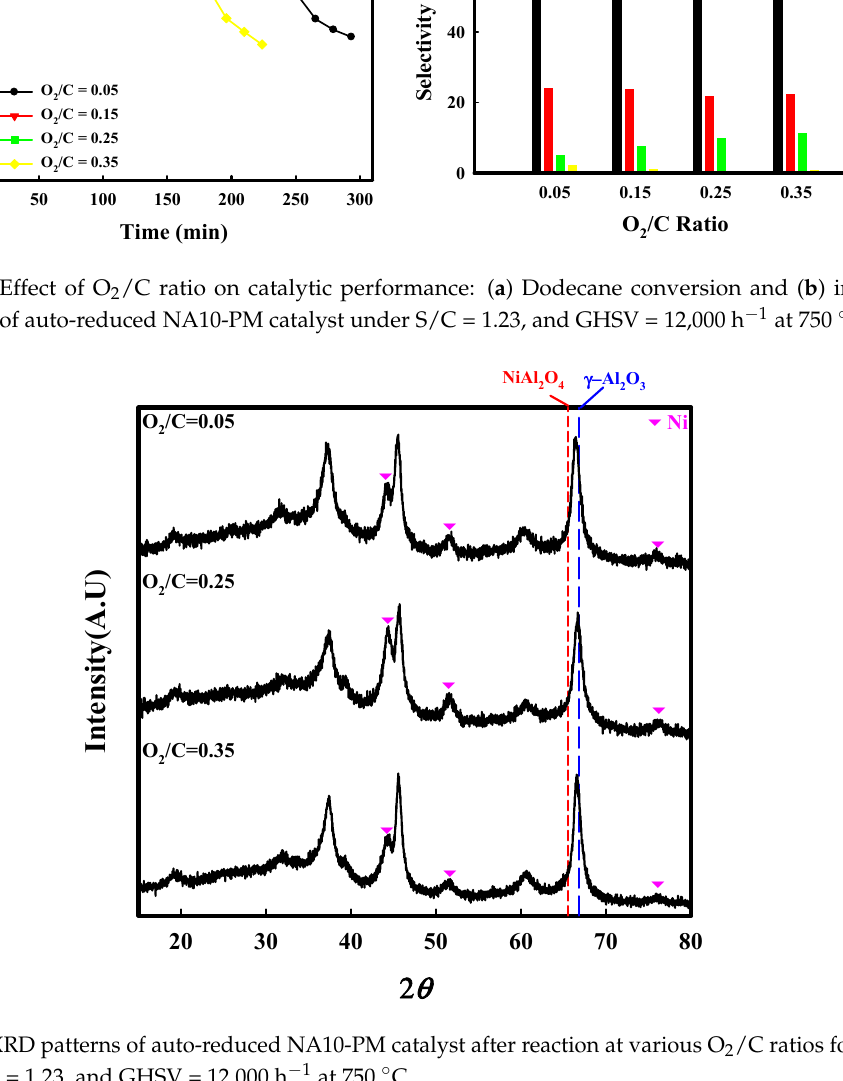
Figure 9. XRD patterns of auto-reduced NA10-PM catalyst after reaction at various O 2 /C ratios for 5 h under S/C = 1.23, and GHSV = 12,000 h − 1 at 750 °C.